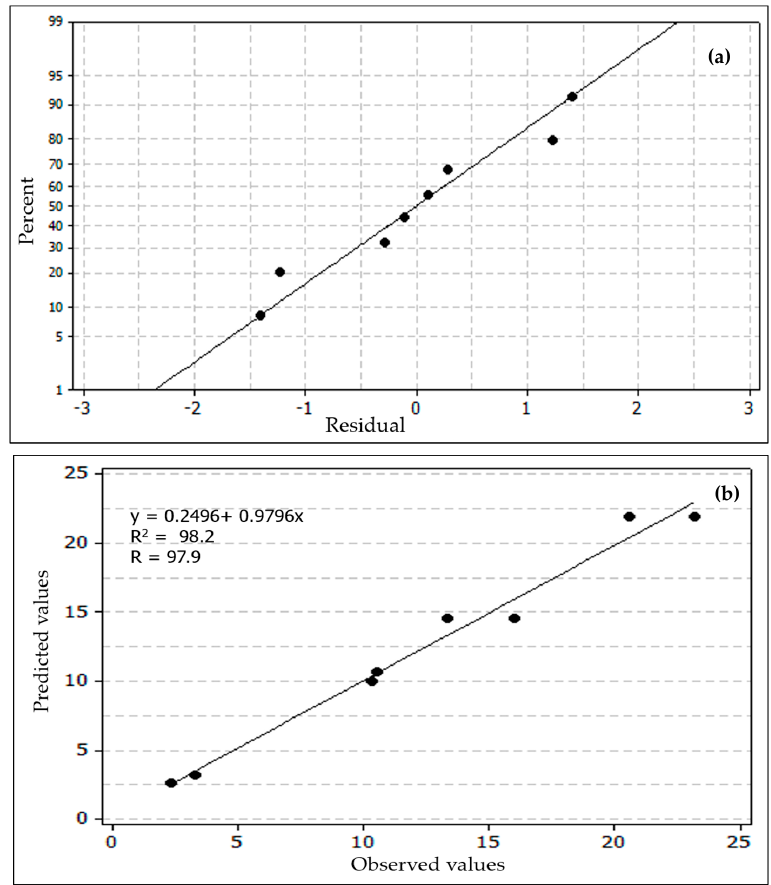
Figure 3. ( a ) Predicted values vs. the experimental values for the desorption of MB from the clay adsorbent coating while ( b ) Normal probability plot of the standardized residual.